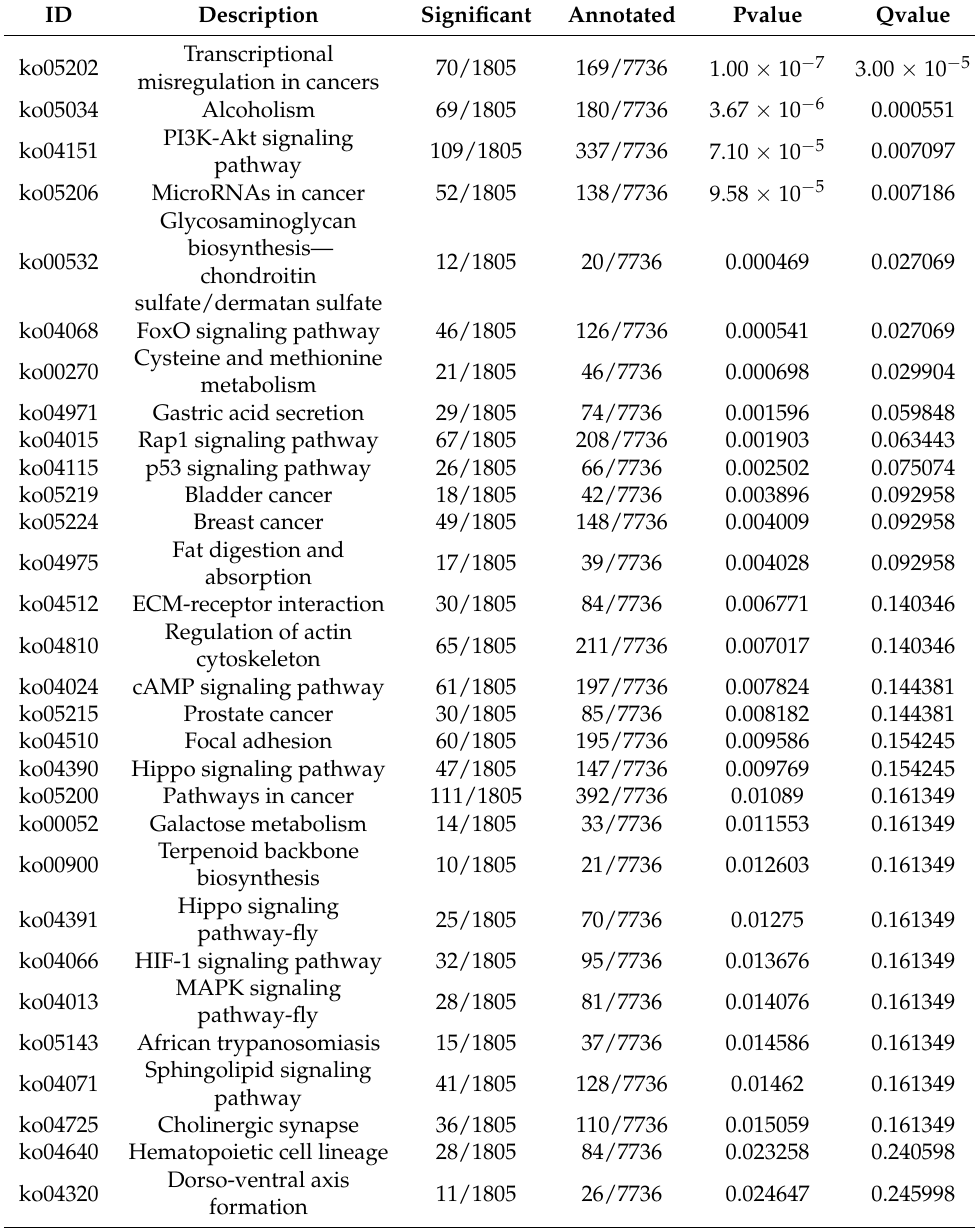
Table 1. The top 30 DGEs via KEGG enrichment